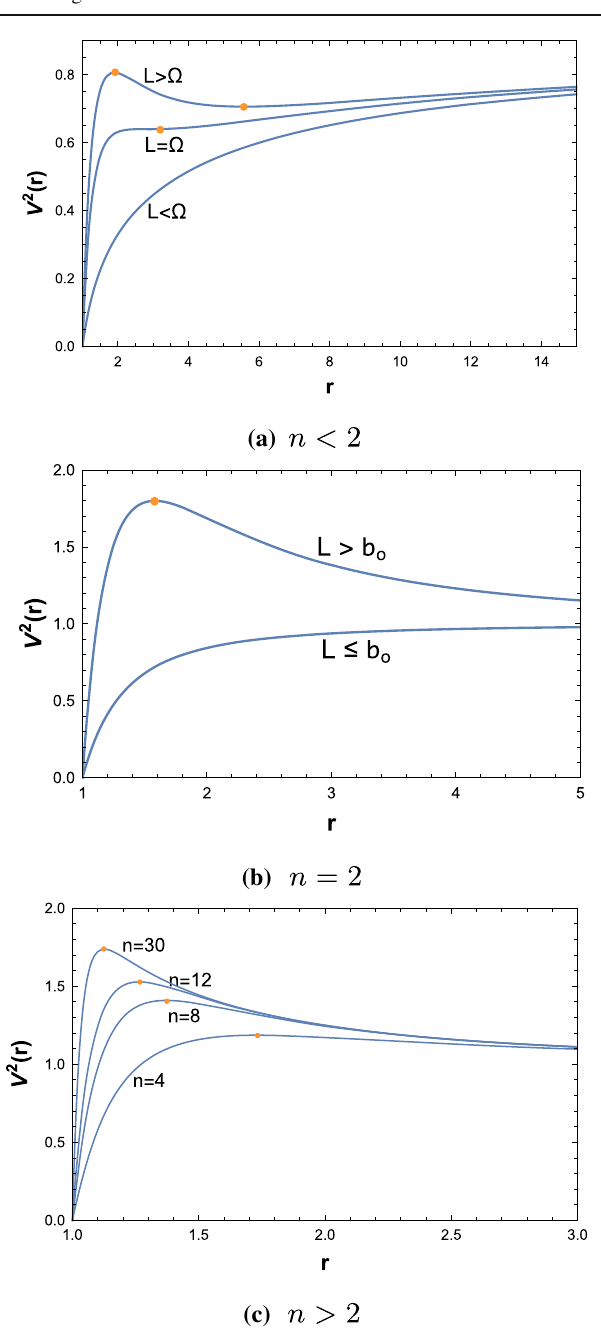
Fig. 4 Behavior of V 2 ( r ) v s . r in different cases. Note that this graph does not incorporate the (cid:14)( r ) contribution near the throat and hence is not valid near b o ; a n < 2, b n = 2, c n > 2